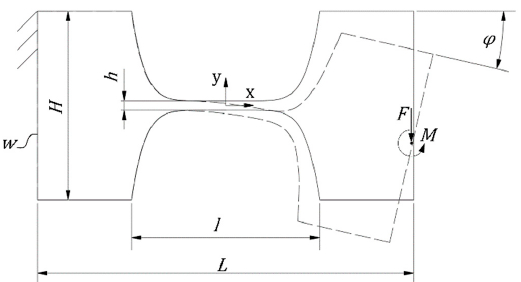
Figure 2. Schematic illustration of a single flexure hinge with indicated elastic deformation as used for the calculation and geometric parameters: maximum height of the hinge 𝐻 , minimal hinge size ℎ , width (out-of-plane thickness) of the hinge 𝑤 , length of the hinge 𝑙, bending angle 𝜑 , force 𝐹 and momentum 𝑀 . Table 1. Geometrical parameters according to Figures 2 and 3 ( 𝑤 = 100 µm) and theoretical stiffness results for a single hinge and for the entire MEMS-based weighing cell systems in direction (dir.) of motion ( − y) and out-of-plane direction ( − z), according to Figure 4a).